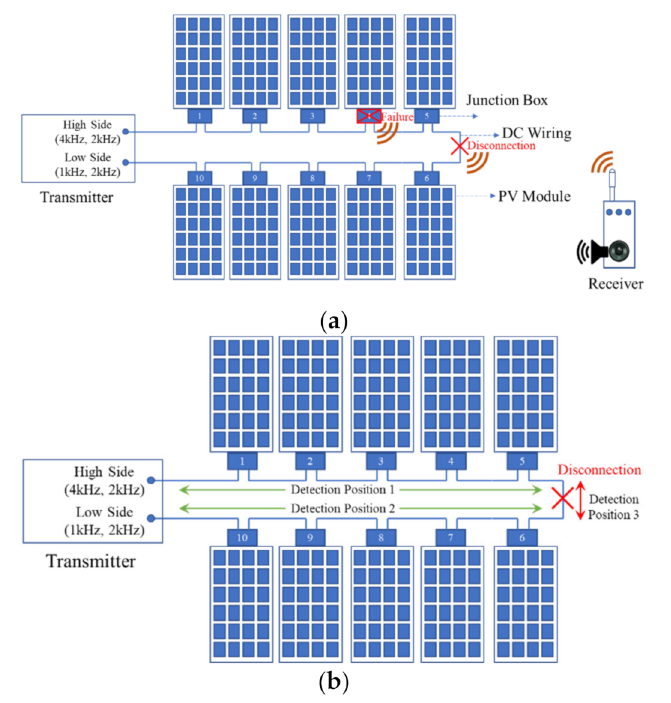
Figure 14. Detection method the disconnection positions in a PV system: ( a ) disconnection detecting method; ( b ) classification of the detecting area.